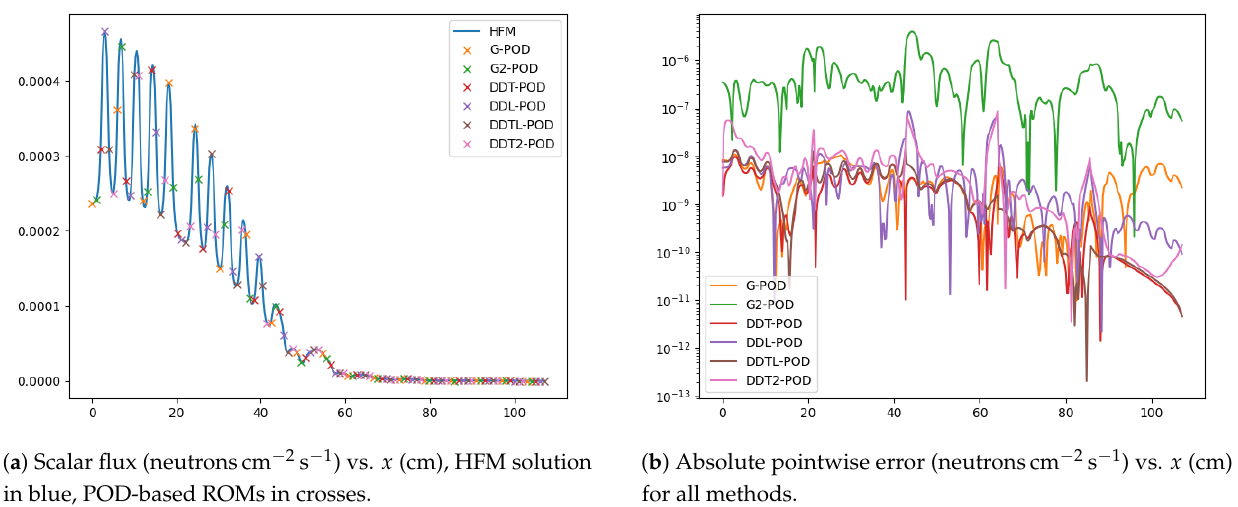
Figure 7. Scalar flux for Energy Group 13 for the HFM (blue) and POD methods and the pointwise error between them with parameters R 1 = 2, R 2 = 2, R 3 = 1, R 4 = 1, R 5 =